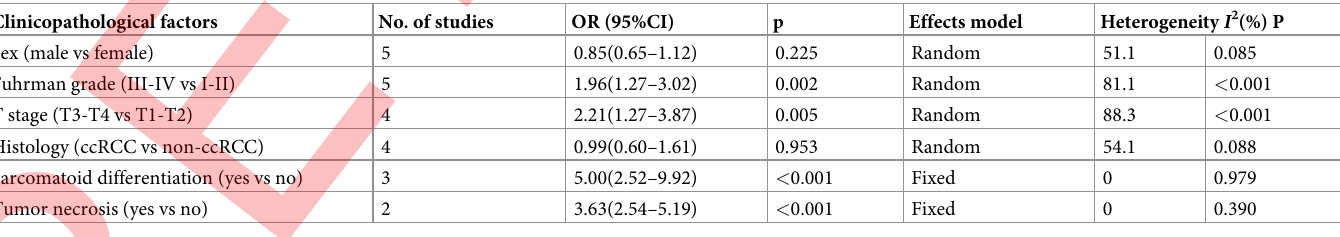
Table 3. Results of the correlation of PNI with clinicopathologic characteristics of patients with RCC. Clinicopathological